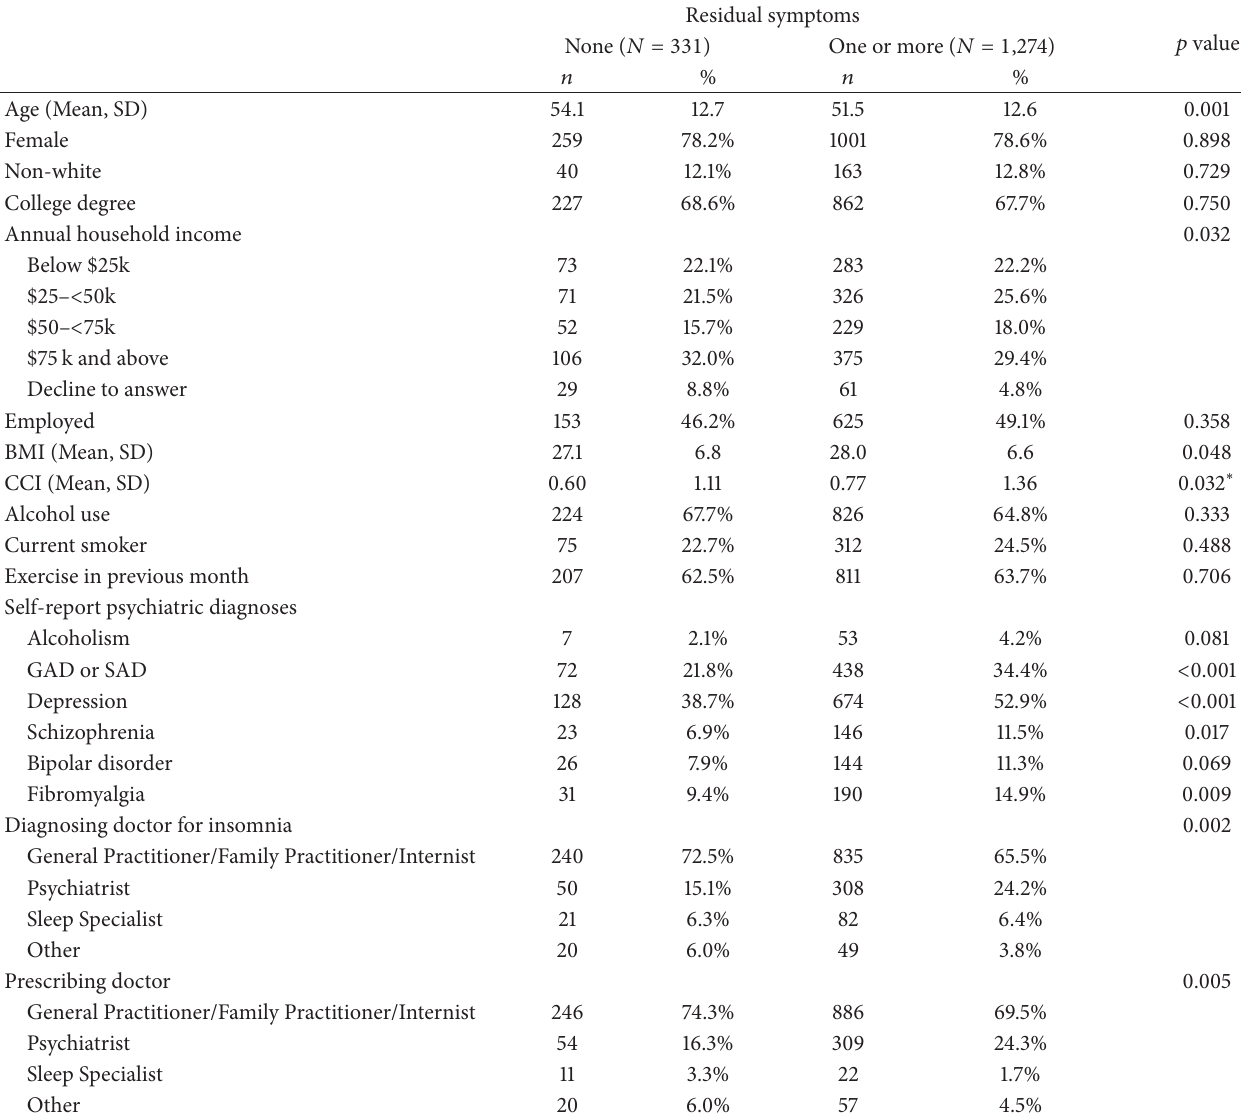
Table 2: Respondent characteristics by presence of residual symptoms.